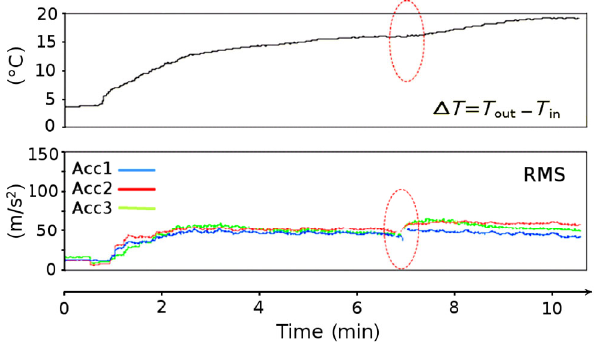
Fig. 16 Arising of scuffing failure: (a) increase in out-of-mesh temperature and (b) change in acceleration RMS value.